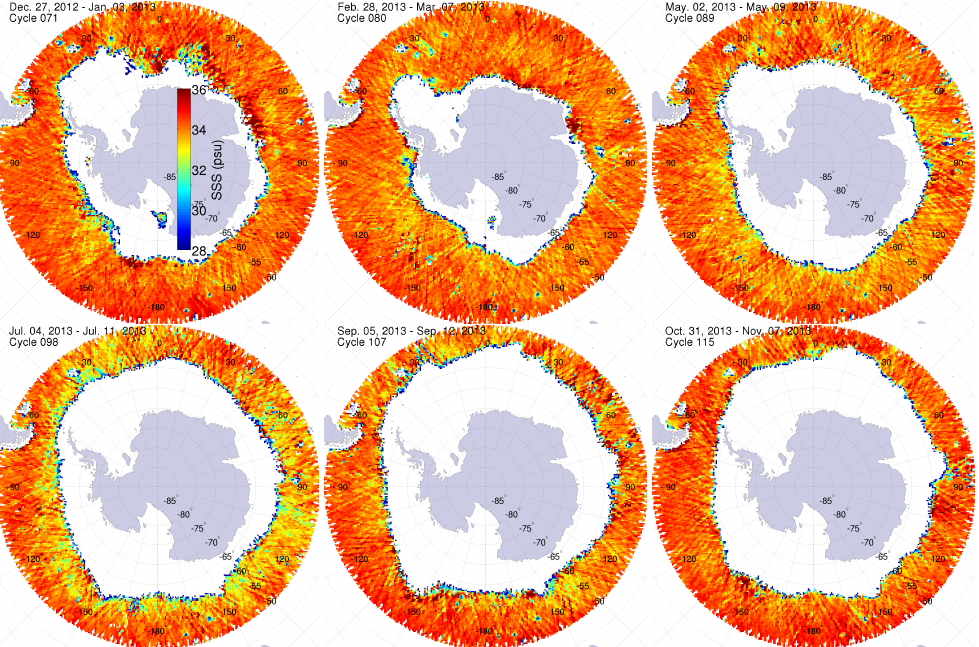
Fig. 18. Maps of SSS3b over the SH high latitudes for cycles every other month in 2013. Grid cells where the land fraction was more than 0.25 were masked.